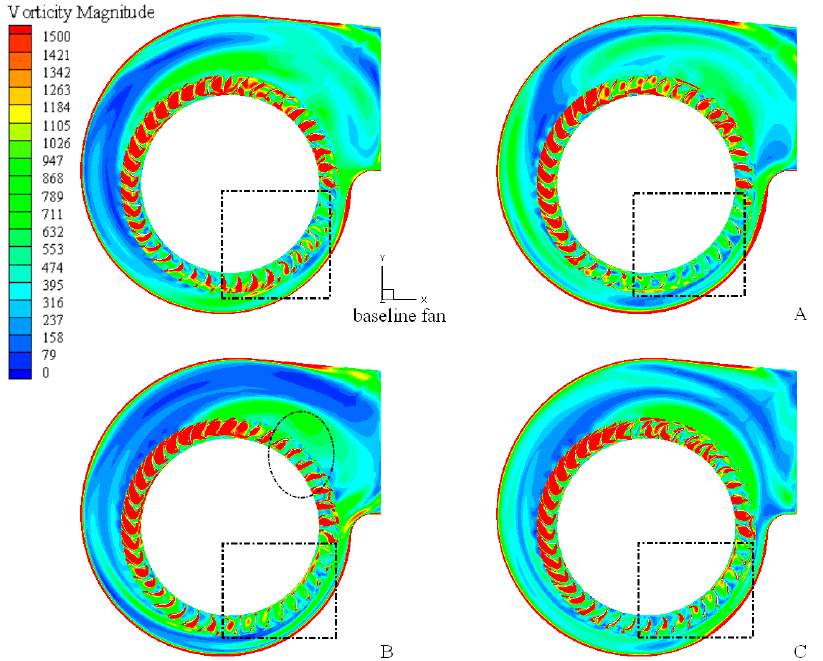
Figure 16. Contour of vorticity magnitude for the z = 75 mm plane at a low flow rate Q / Q n = 0.483: ( A ) model-A; ( B ) model-B; ( C ) model-C.